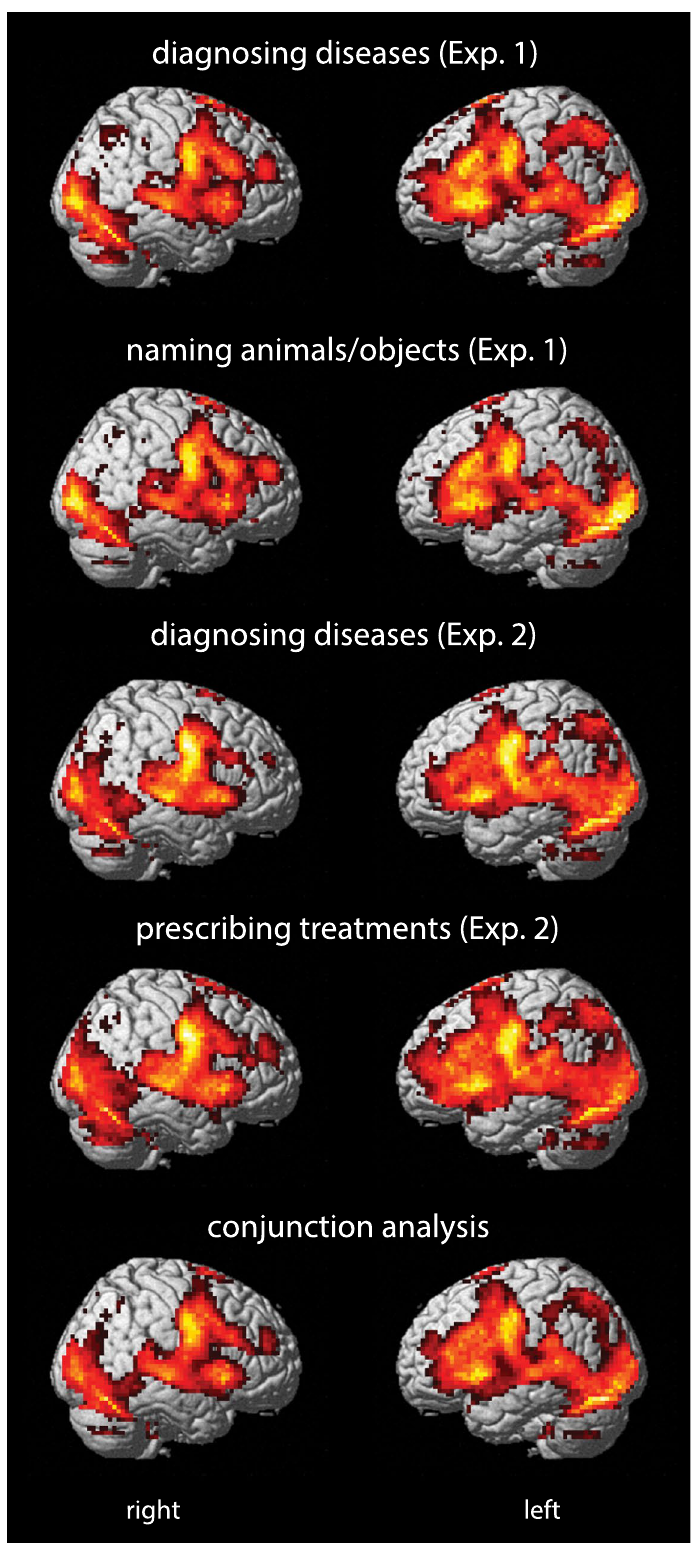
Figure 2. BOLD responses * to task effects in Experiments 1 and 2 versus control baseline and conjunction analyses of all tasks * p < 0.05 family-wise error (FWE) corrected; extent threshold k E ≥ 10. Statistical parametric maps (SPMs) rendered on an International Consortium for Brain Mapping (ICBM) individual